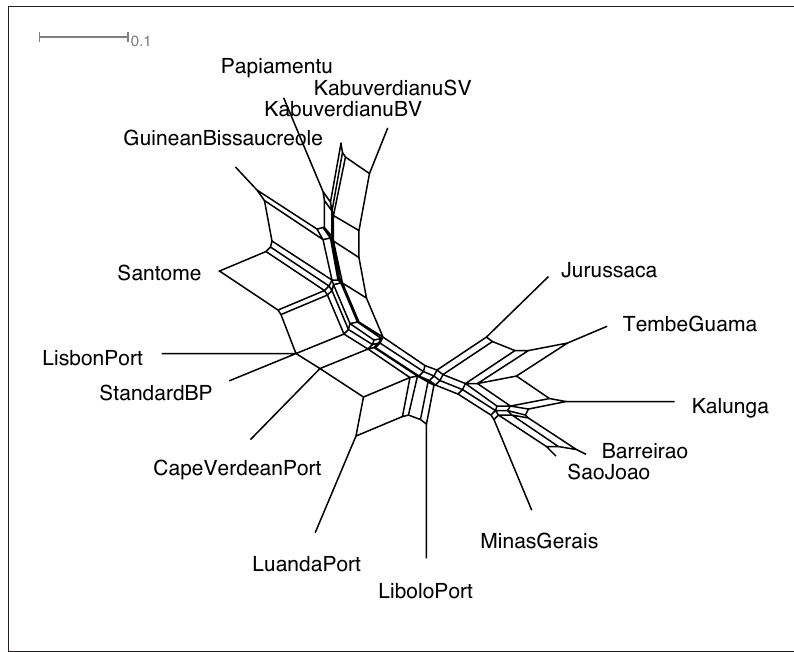
Figure 1: Split network of a Neighbour-Net of the 57 dialectal features of the 16 language